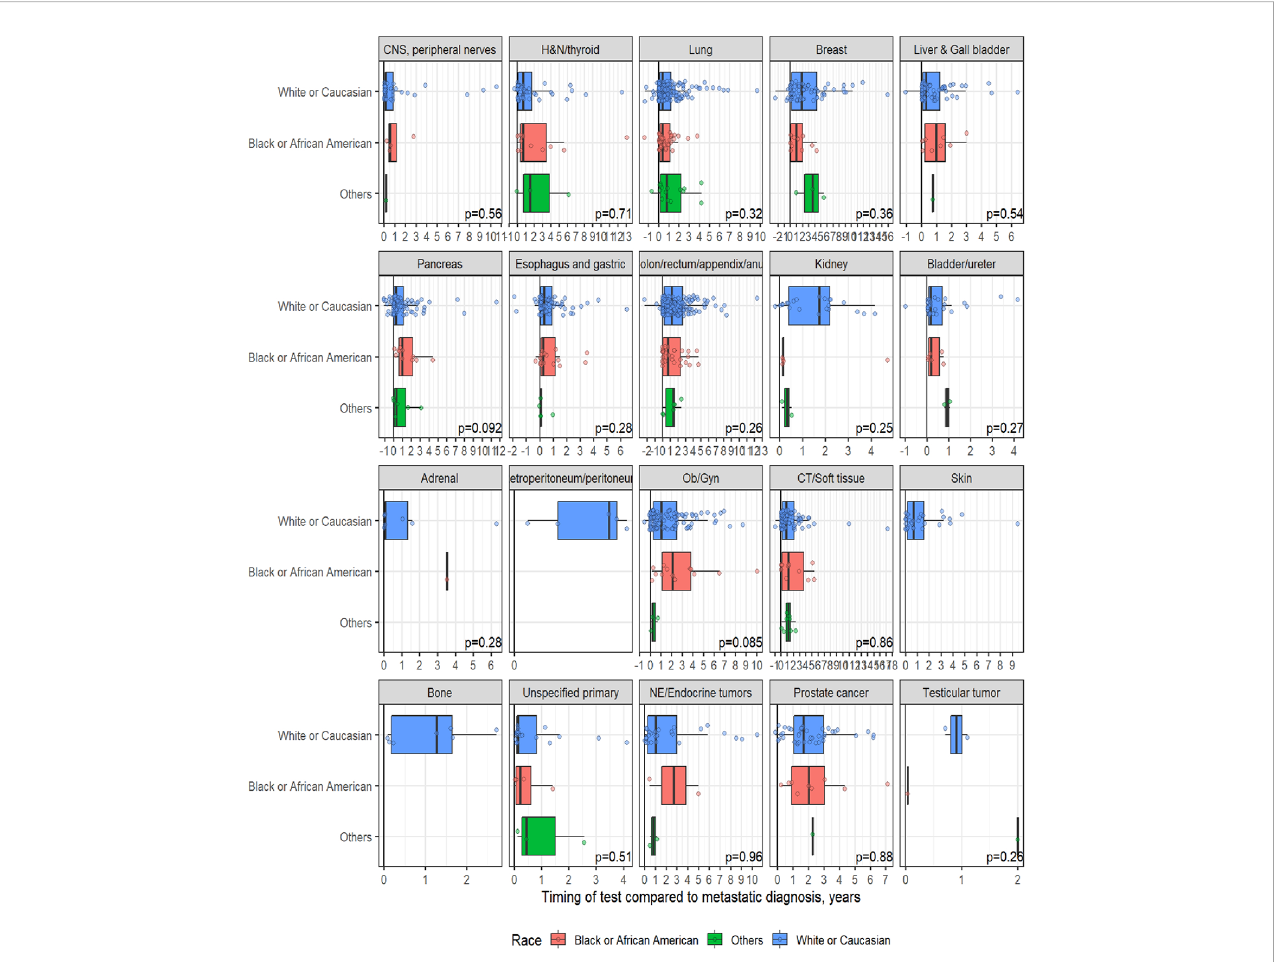
FIGURE 2 Effect of Race on timing of comprehensive genomic pro fi ling (CGP) test after adjusting for